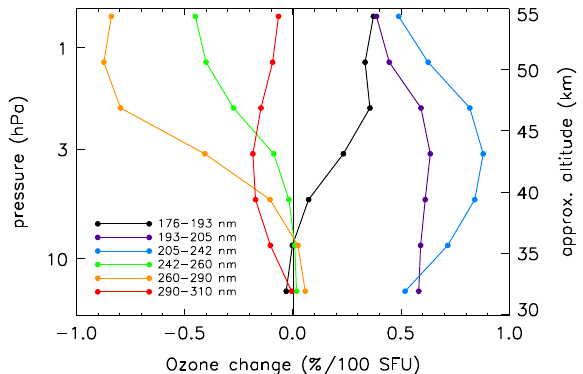
Fig. 2. The equatorial D O 3 ( z ) profiles resulting from the change in SATIRE-S spectrum separately in the six spectral bands used in the linear model. These are the columns of matrix M defined in